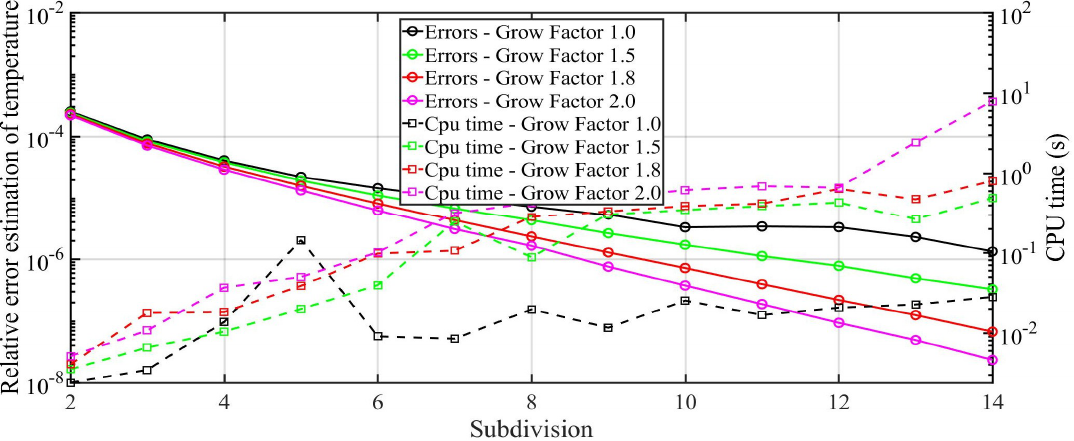
Figure 14. Relative maximum temperature error estimations of the inner surface (Case 2).